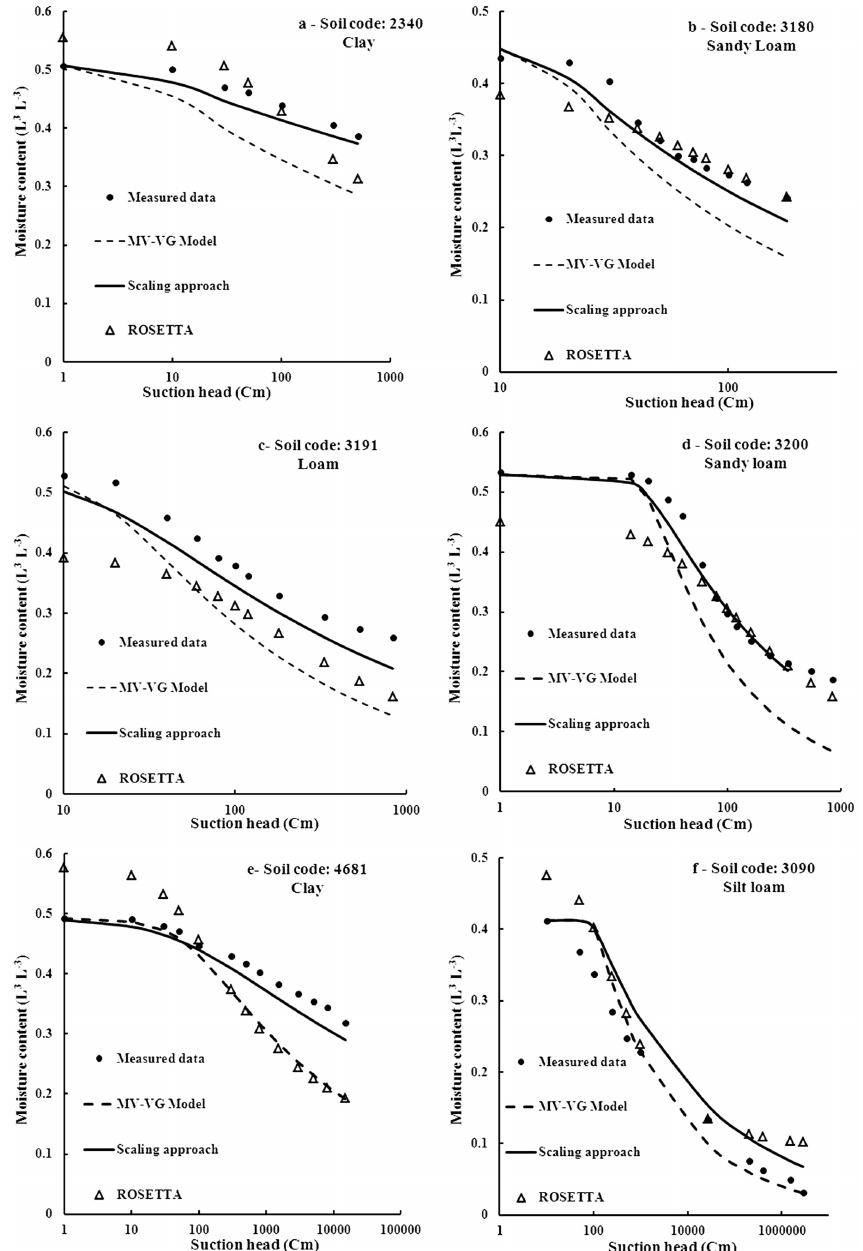
Figure 2. Examples of measured vs. predicted soil moisture characteristic curve (SMC) for each texture using the integrated MV–VG model (Eq. 9), scaling approach (Eq. 12) and ROSETTA: for (a) clay soil, (b) sandy loam soil, (c) loam soil, (d) sandy loam soil, (e) clay soil and (f) silt loam